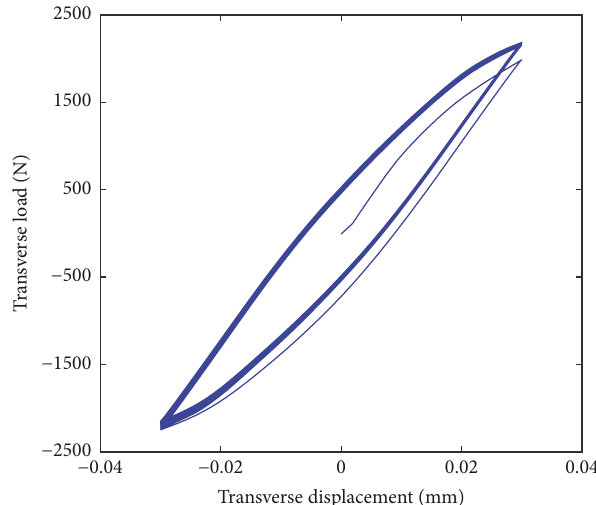
Figure 27: Hysteresis loops of transverse displacement and